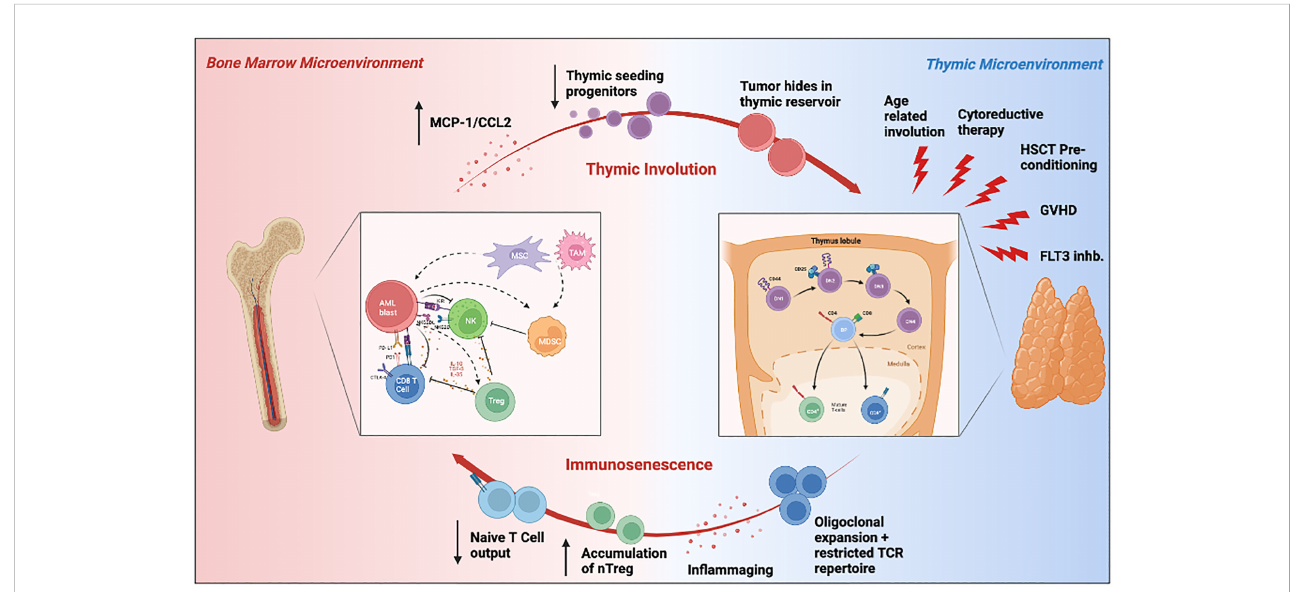
FIGURE 3 Schematic illustration summarizing the crosstalk between the bone marrow and thymic microenvironment, and its in fl uence on the AML TME. Hematopoietic stem cells derived from the leukemic bone marrow microenvironment can travel to the thymus where they differentiate into T cells. The resulting T cells are then exported to the periphery, where they may then recirculate back into the bone marrow as tumor in fi ltrating lymphocytes. Environmental insults such as aging, cytoreductive therapy, HSCT pre-conditioning, and FLT3 inhibition may impair thymopoiesis and subsequently promote tumor immune evasion through immunosenscence. The immunosuppressive bone marrow microenvironment can also independently impair thymic function through MCP-1/CCl2 expression and reduction in thymic seeding progenitors. Elements of this fi gure were generated using